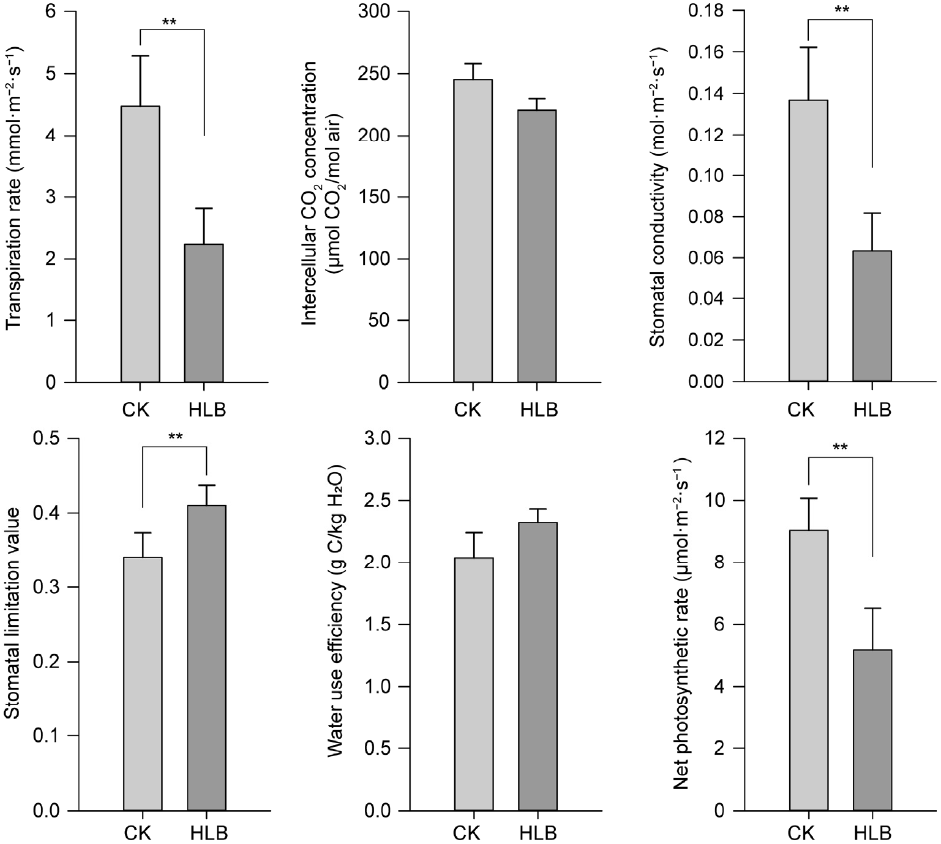
Figure 2. Changes of photosynthetic parameters in leaves of ‘Pujiang Xiangcheng’ after HLB infection. ** indicates extremely significant difference ( p < 0.01) using a Student’s t -test. The bar plots were presented as mean ± standard deviation ( n = 3).